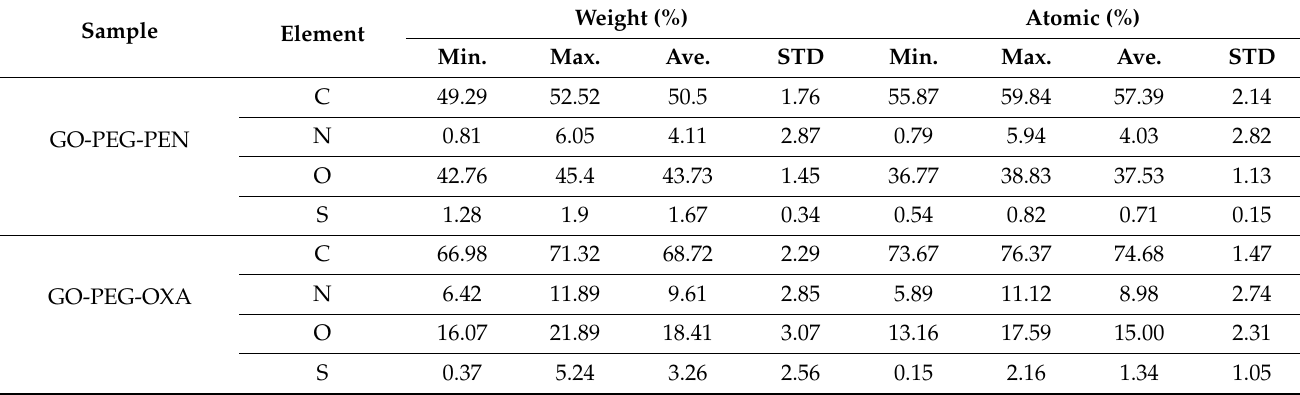
Table 2. The EDX results for GO-PEG-OXA and GO-PEG-PEN composites.